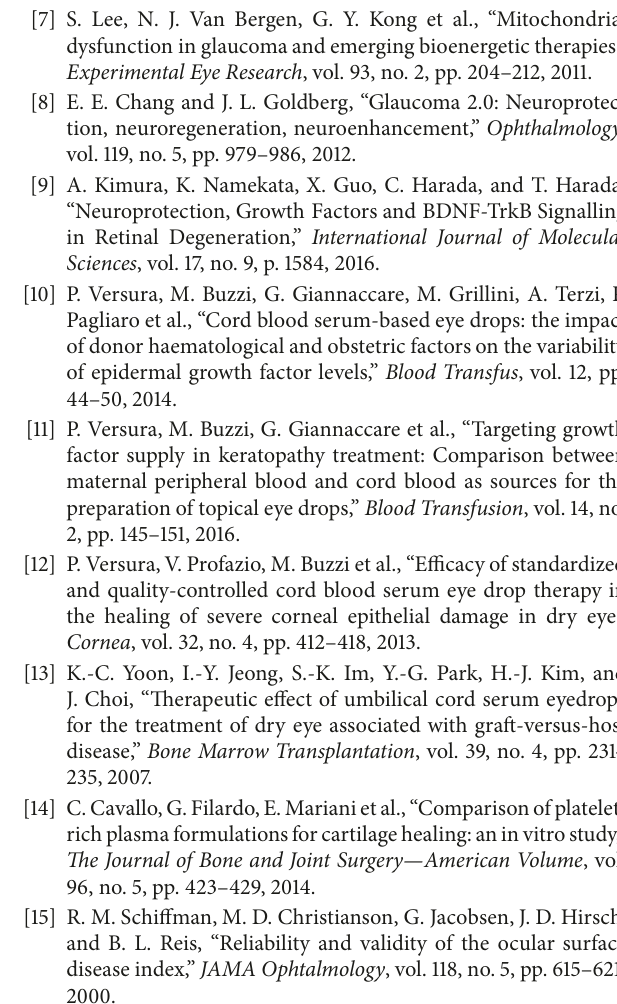
with high potential to be expanded on a more numerous and prospective